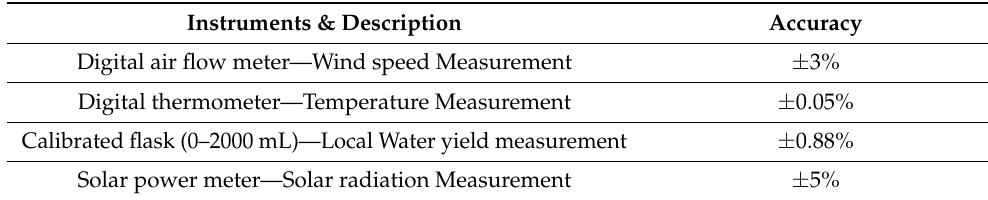
Table 2. Technical specifications of